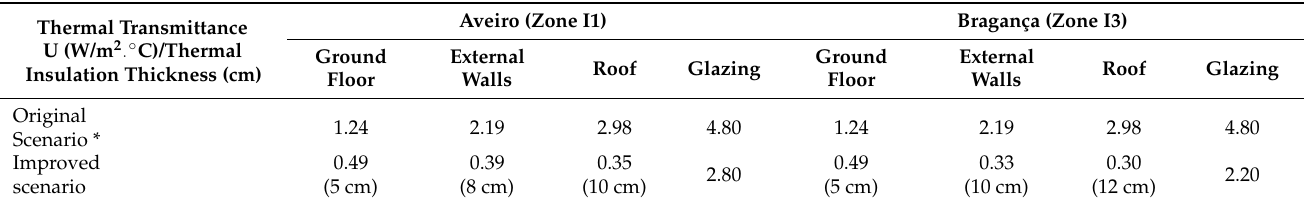
Table 1. Thermal characteristics of the improved building envelope.